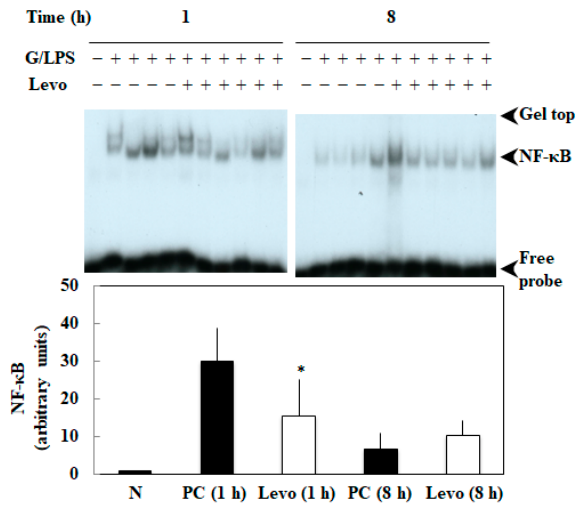
Figure 2. Effect of levosimendan on activation of NF- κ B in the livers of D-galactosamine hydrochlo- ride and lipopolysaccharide (GalN/LPS) rats. A mixture of 500 mg/kg GalN and 2.5 µg/kg LPS (G/LPS) was injected. The GalN/LPS rats were treated with levosimendan at 4 mg/kg (Levo).Upper, activation of NF- κ B was examined by electrophoretic mobility shift assay. Lower, the bands corre- sponding to NF- κ B were quantitated by densitometry. N, normal rat; PC, positive control. “+” indi- cates that G/LPS or Levo was administered; "-" indicates that GalN/LPS or Levo was not adminis- tered.* p < 0.05 compared with PC.